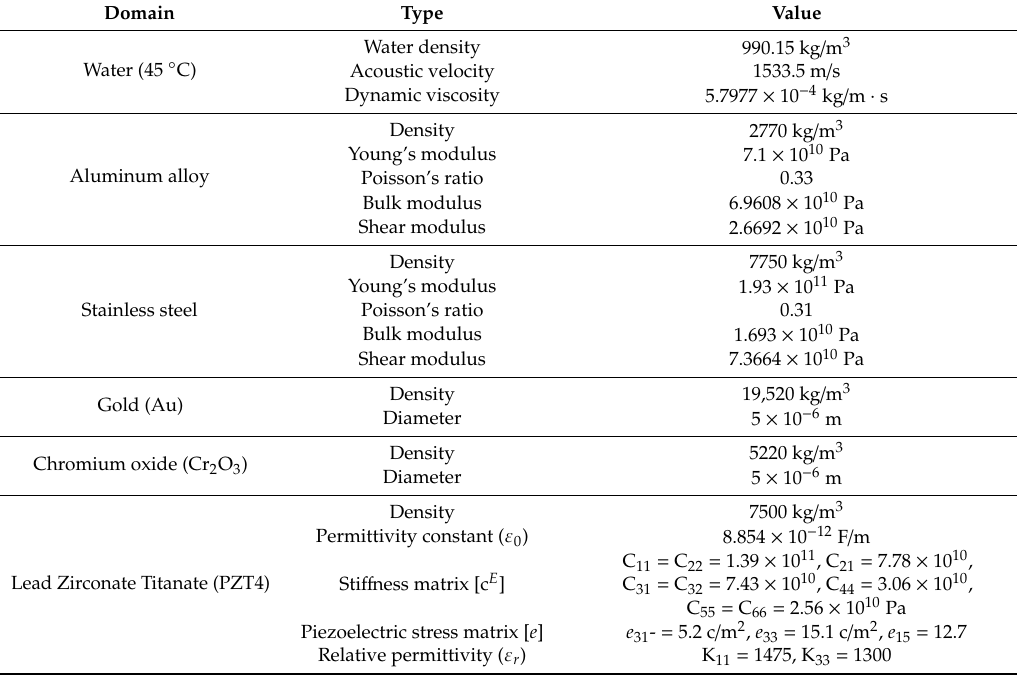
( b ) Figure 5. Fluid models of ( a ) circular inlet and ( b ) rectangular inlet.